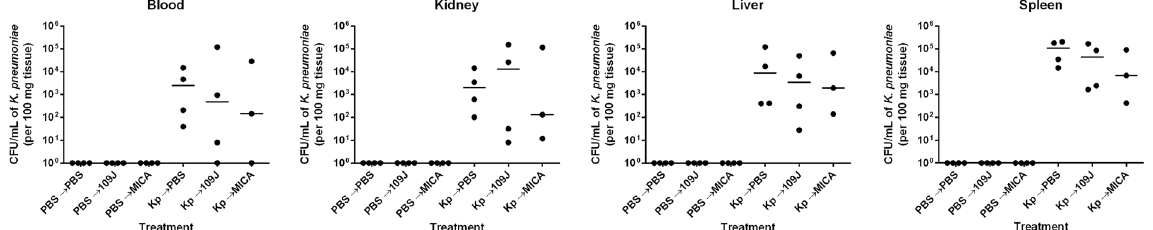
Figure 5. K . pneumoniae bacterial burden within rat blood and organs after treatment scheme #1 with predatory bacteria. K . pneumoniae (or PBS for control groups) was initially introduced into rats via intravenous inoculation. Animals were then treated via tail vein injection with PBS, B. bacteriovorus 109J or M. aeruginosavorus (MICA) at 30 minutes, 6, 12, and 18 hours post-injection. At 24 hours, blood was collected and kidneys, livers, and spleens were harvested, homogenized, and plated on MacConkey agar plates to recover K. pneumoniae CFUs. Four rats per treatment group were used at each time point. Each data point represents a single rat’s respective bacterial load. Horizontal lines represent the median of the results from each treatment set. Significant differences between treatment groups and respective control were performed using the Mann- Whitney